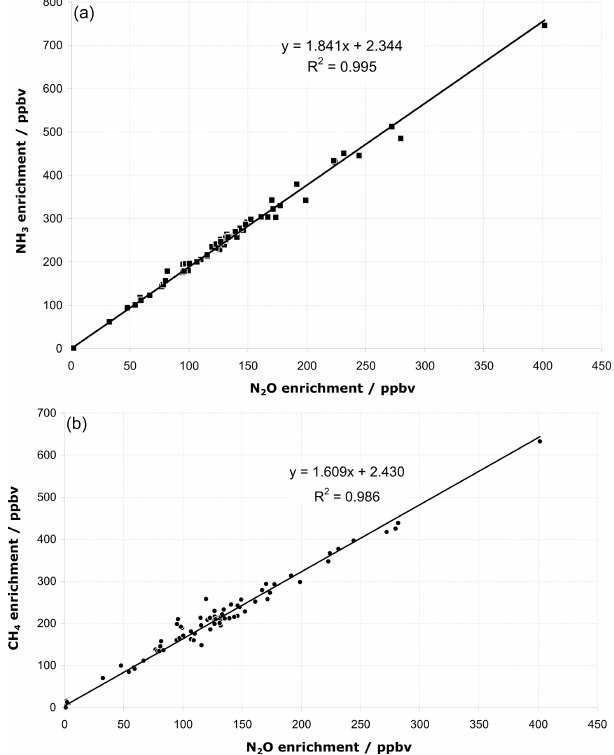
Figure 6. Linear regression analysis of the OP-FTIR-measured en- richments shown in Fig. 5 between 14:45 and 16:25LT of NH 3 vs. N 2 O (a) and CH 4 vs. N 2 O (b) . Table 6. Ratios of mole fractions of CH 4 and N 2 O between air sam- ples and OP-FTIR including Bomem MB100 and Bruker IRcube spectrometers ∗ .